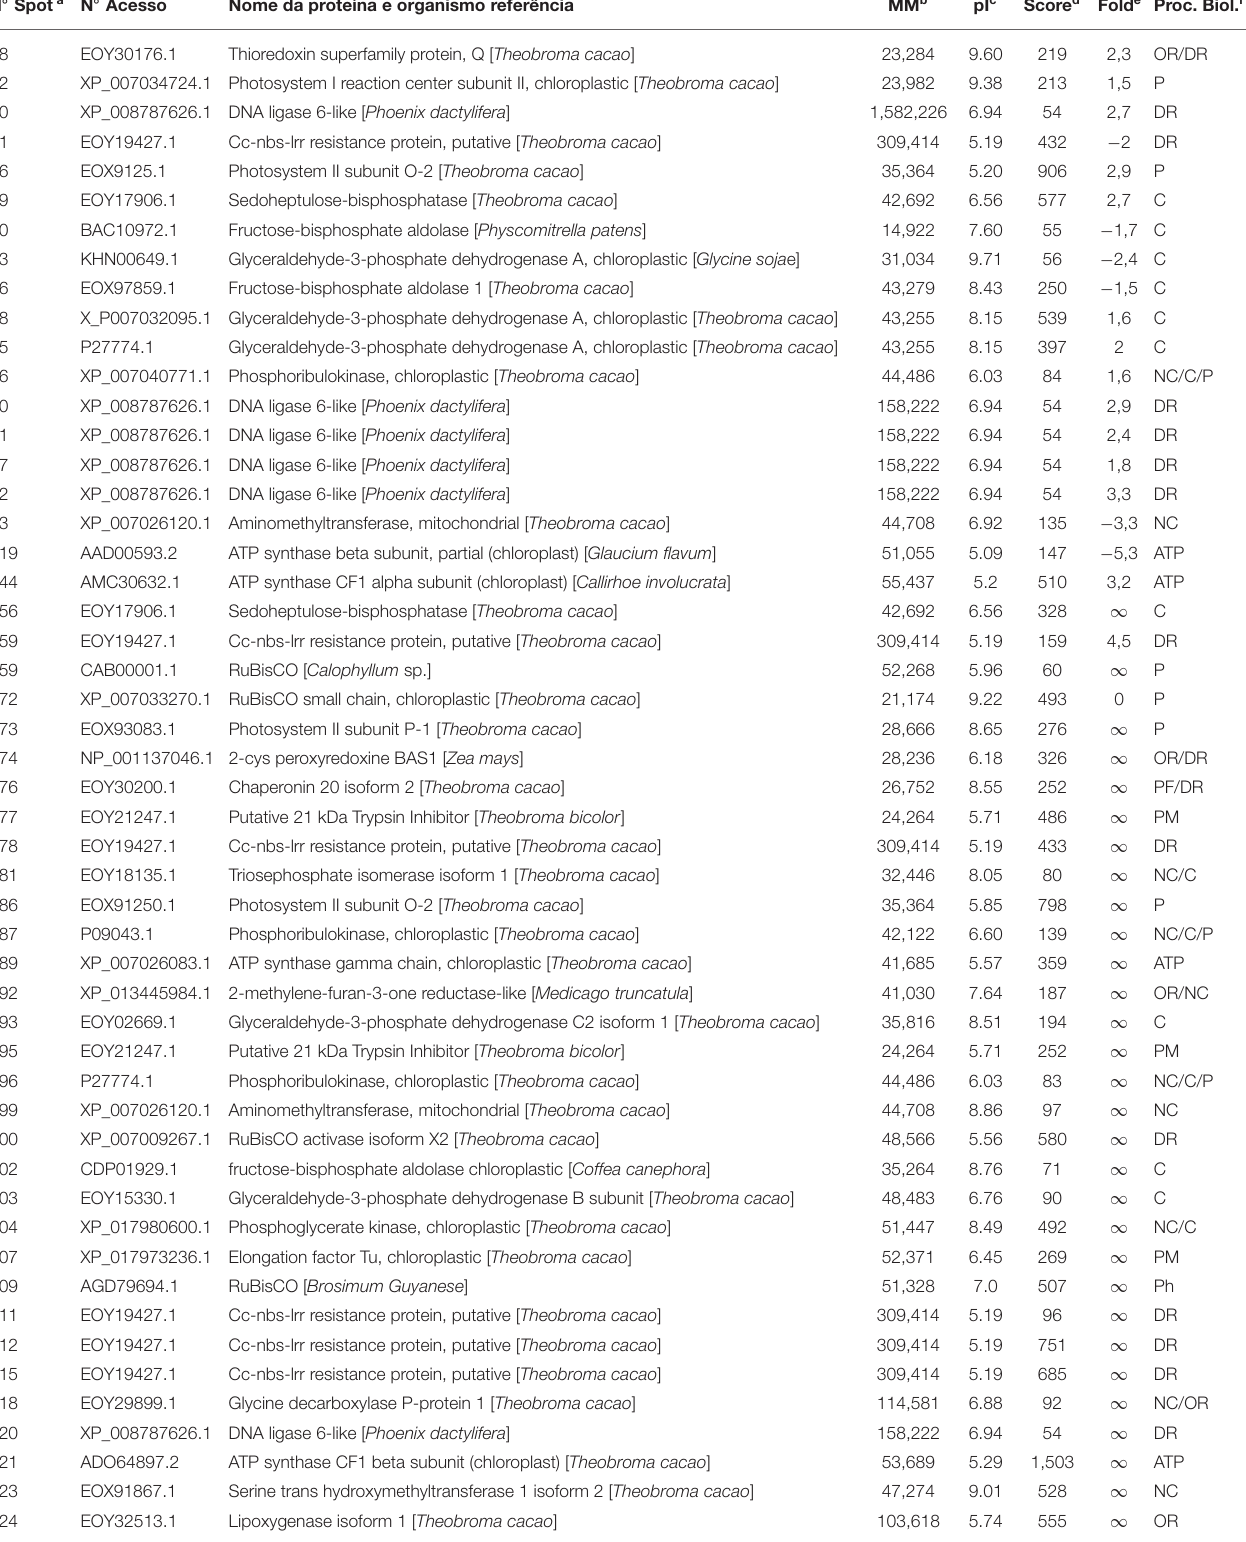
TABLE 1 | Proteins identified through mass spectrometry in leaves of the PA 150 resistant clone of T. cacao inoculated and not inoculated with P. palmivora. N ◦ Spot a N ◦ Acesso Nome da proteína e organismo referência Score d Fold e Proc. Biol.